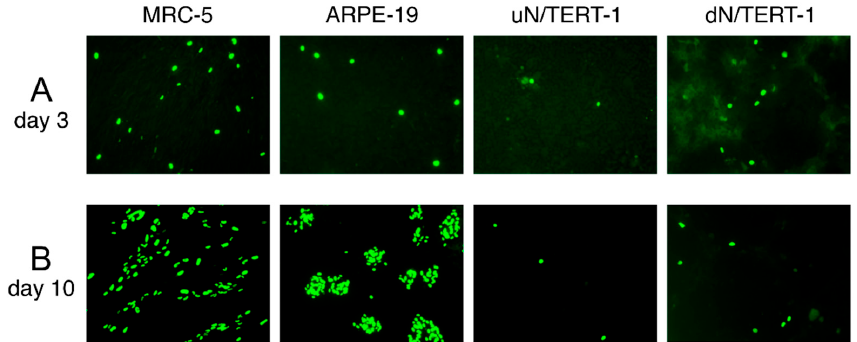
Figure 4. Using Ig ‐ KG ‐ H2 to evaluate CMV tropisms for different cell types. ( A ) 96 ‐ well plate cultures MRC-5, ARPE-19, and N/TERT-1 cells that were either undifferentiated (uN/TERT-1) or differentiated of MRC ‐ 5, ARPE ‐ 19, and N/TERT ‐ 1 cells that were either undifferentiated (uN/TERT ‐ 1) or (dN/TERT-1) were inoculated with 500 pfu/well of Ig-KG-H2 (stock H2b) and stained for IE1/IE2 differentiated (dN/TERT ‐ 1) were inoculated with 500 pfu/well of Ig ‐ KG ‐ H2 (stock H2b) and stained proteins at three days ( A ) or ten days post-infection ( B ). Images were taken using a 10 × for IE1/IE2 proteins at three days ( A ) or ten days post ‐ infection ( B ). Images were taken using a 10×